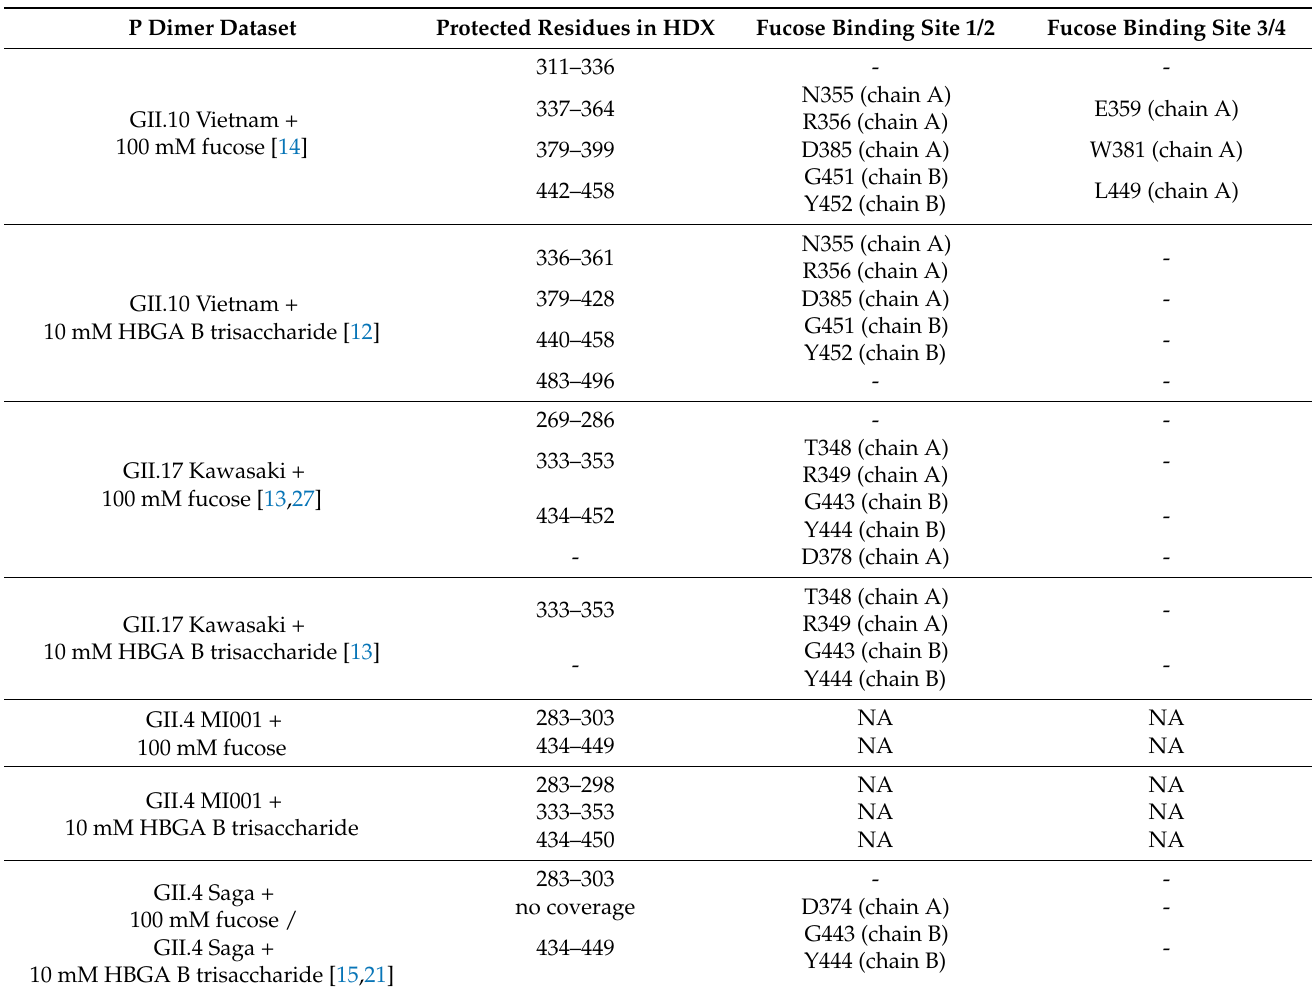
Table 1. Comparison of protected residues in HDX with known glycan interactions in crystal structures. The canonical binding sites 1/2 are conserved for many strains and glycans, binding sites 3/4 have so far only been detected in GII.10 Vietnam. For GII.17 Kawasaki only crystal structures with fucose and A trisaccharide are available, so protected residues for B trisaccharide are compared to binding sites seen for A trisaccharide. P dimer chain annotations are given for fucose binding sites 1 and 3. No crystal structure is available for GII.4 MI001 P dimers, so binding sites are marked as unknown (NA). Protected residues for wildtype GII.4 Saga P dimers [15] are shown for comparison. P Dimer